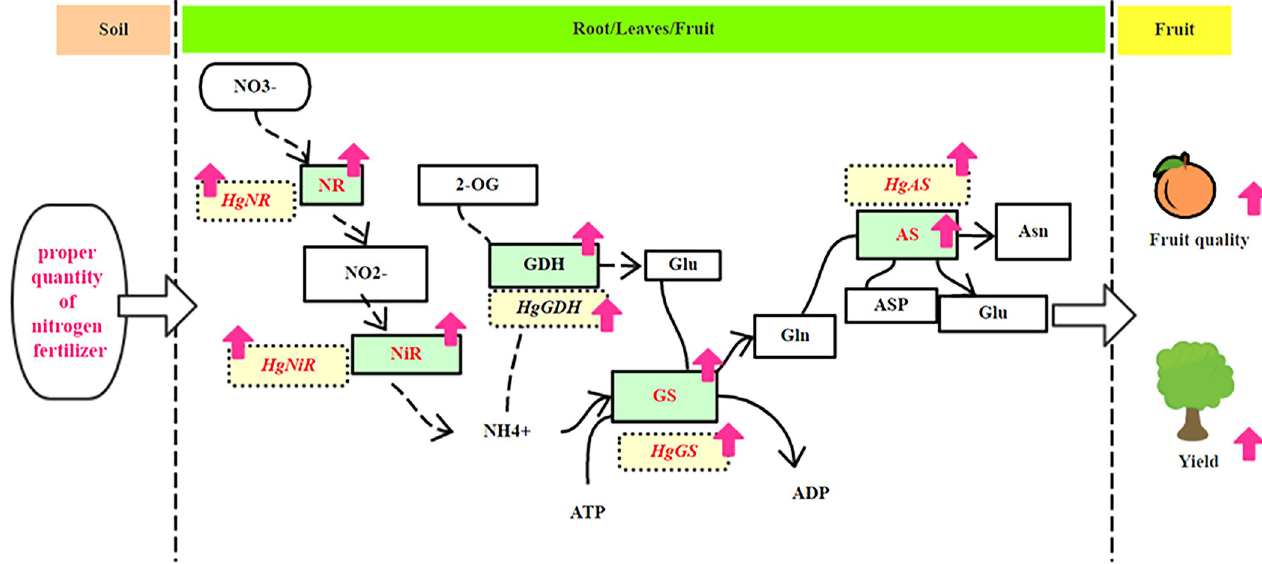
Fig 9. Graphical abstract. The solid and dashed lines denote the pathways of inorganic N metabolism in the citrus cultivar ‘Huangguogan,’ and the red upward arrow indicates that the relevant indicators were upregulated under adequate N supply.